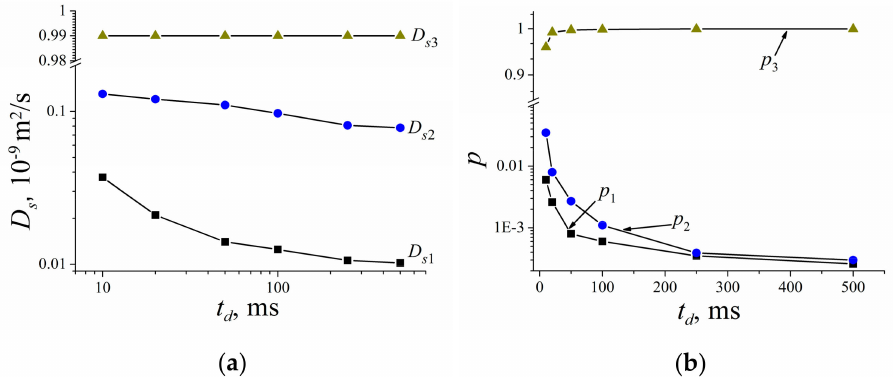
Figure 61. The water self-diffusion coefficient D s1 , D s2 , and D s3 dependences on the diffusion time t d at 35 ◦ C ( a ). The population p 1 , p 2 , and p 3 dependences on the diffusion time t d at 35 ◦ C ( b ) Reprinted with permission from [171]. Copyright 2016 Springer Nature.